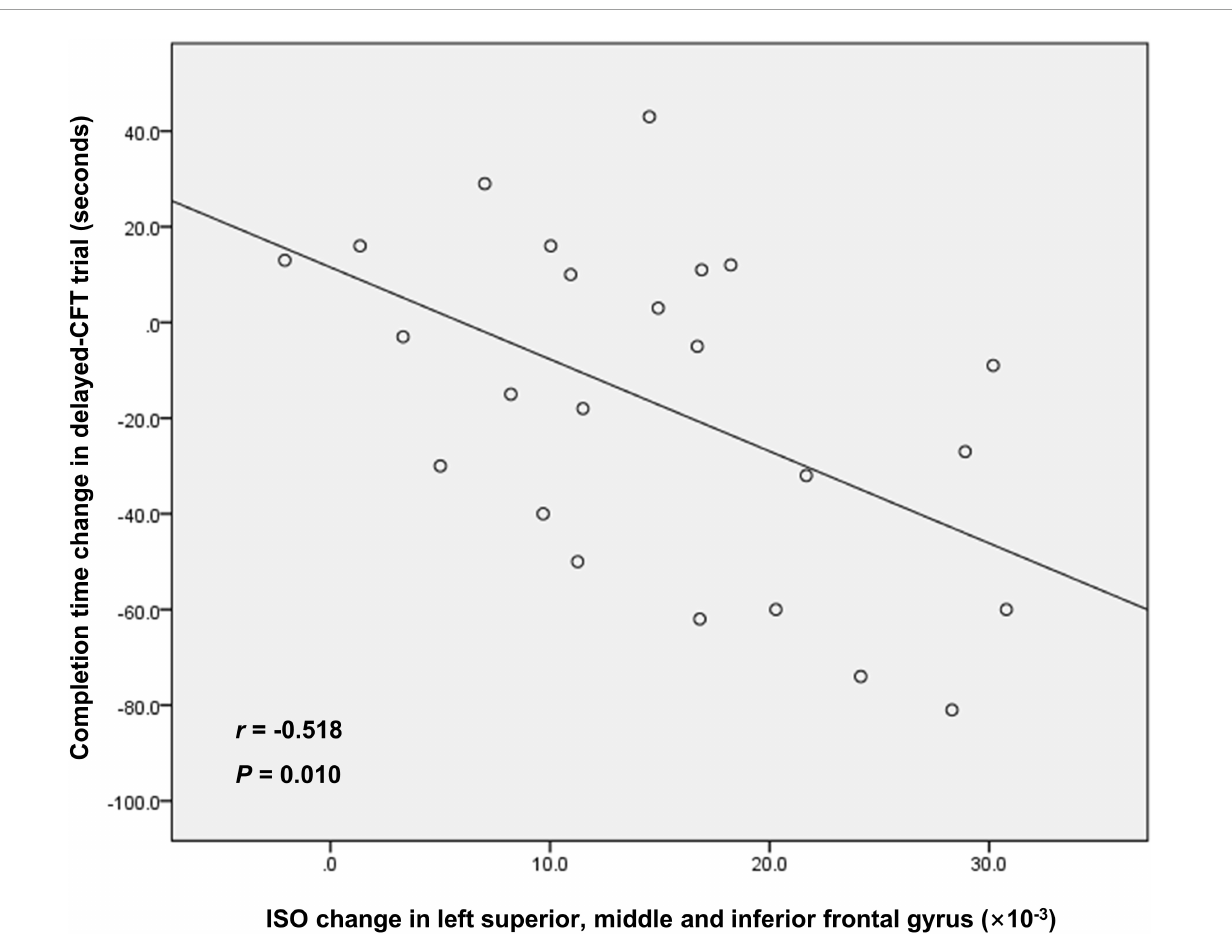
FIGURE3 The correlation between ISO change in left superior, middle, and inferior frontal gyrus and completion time change in delayed-CFT trial. ISO, isotropic volume fraction; CFT, complex figure test.